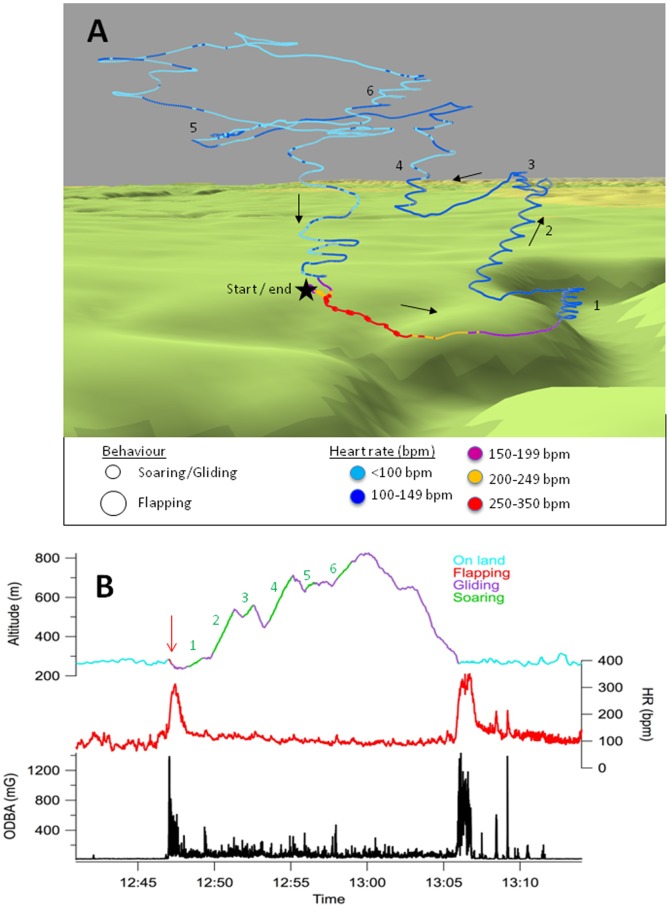
Example of flight track, heart rate and behaviour.A) One of the flight paths followed by the Himalayan griffon vulture under sunny conditions, with information on HR (gradient of colour from red (HR>300 bpm), orange, purple, to blue (HR<100 bpm)) and behaviour (small dots  =  soaring/gliding; large dots  =  flapping) superimposed. The black star marks the start and end of flight and black arrows give the first direction of flight. Soaring phases are numbered in black for an easy correspondence with panel B (see also Fig. S1 for 3-D visualization); B) a time-based projection of altitude (top), heart rate (HR, middle, in red) and an index of body activity based on acceleration signals, highlighting the flapping and walking bouts (ODBA, bottom, in black). For the altitude panel, the colour of the line changes with behaviour (with the flapping bout marked by a red arrow) and the green numbers refer to the same soaring phases as in panel A.